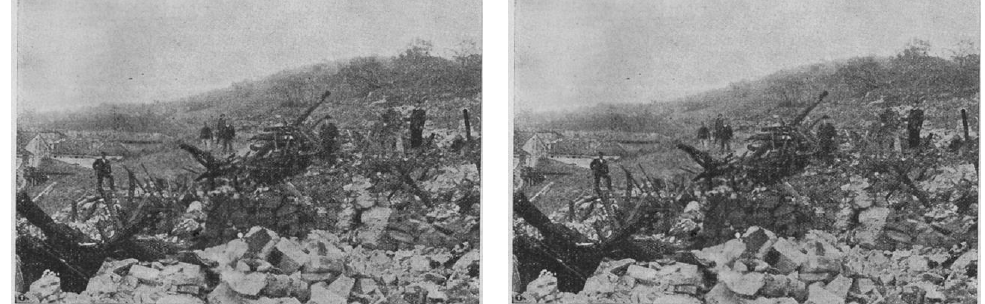
Figure 13. The landslide body ( left , right ) and the damage caused to a retaining wall ( right ) (Source: [67], private archive of Gizzi F.T.).